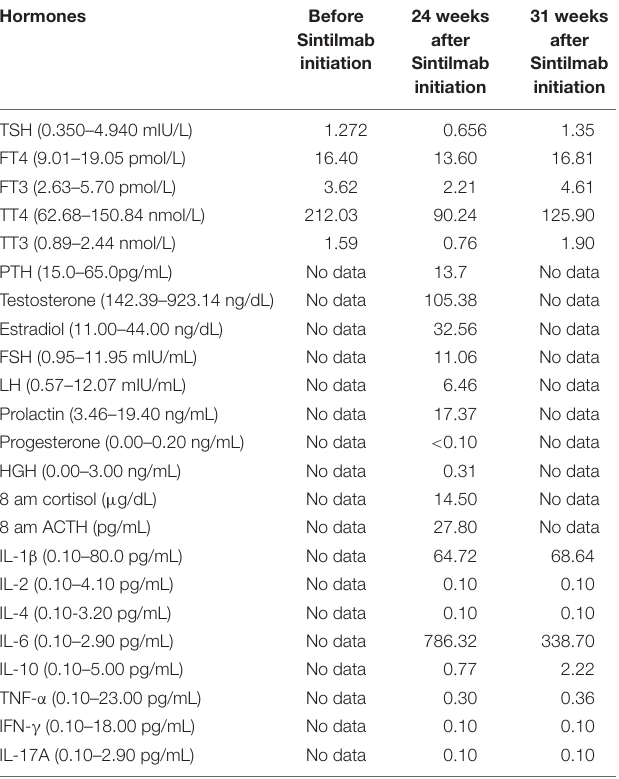
TABLE 1 | Levels of hormones and inflammatory cytokines before and after initiation of Sintilimab. Hormones Before